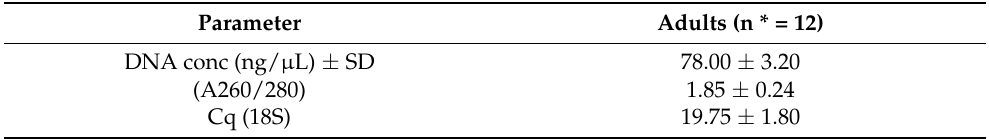
Table 1. Average concentrations of the extracted DNA ( ± SD), absorbance ratio (A260/280), and Cq values for assayed Philaenus italosignus